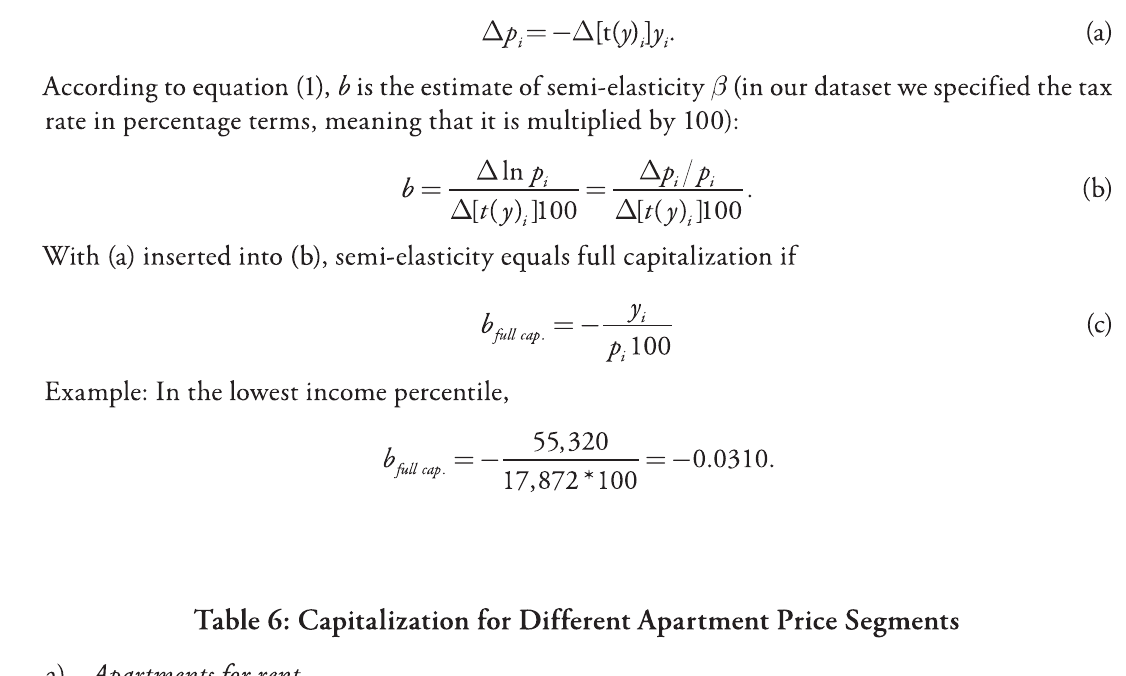
Table 6: Capitalization for Different Apartment Price